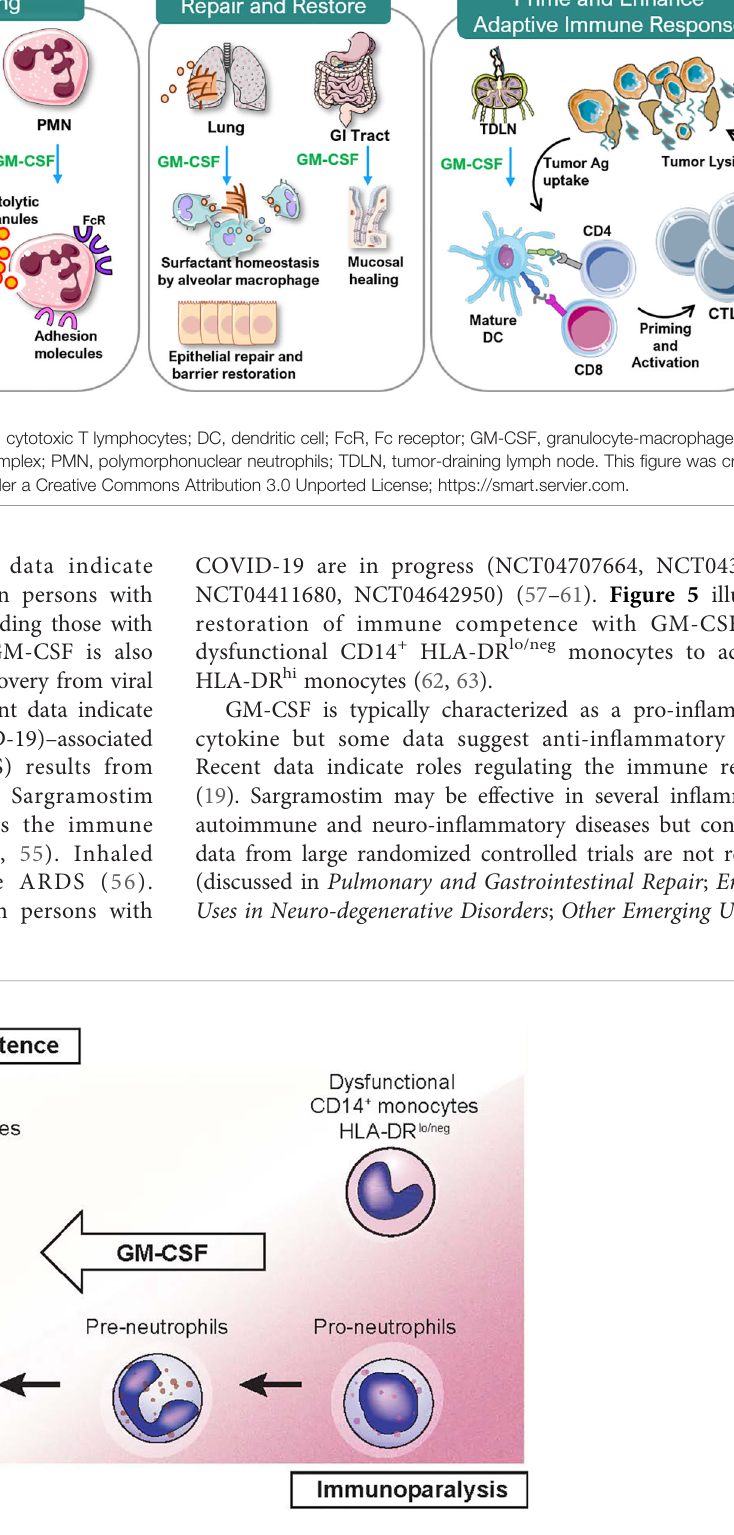
FIGURE 5 | GM-CSF reversal of immune paralysis (modi fi ed from Schulte-Schrepping 2020).